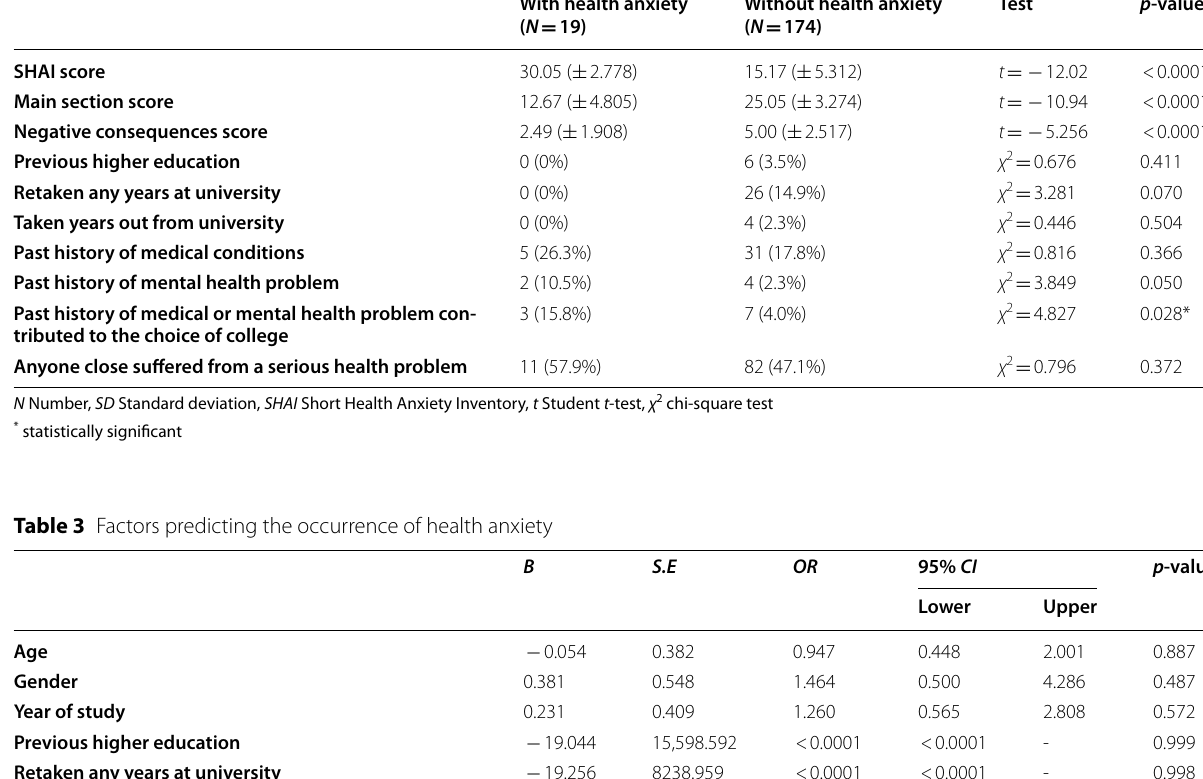
Table 2 Clinical characteristics and background of students with and without health anxiety